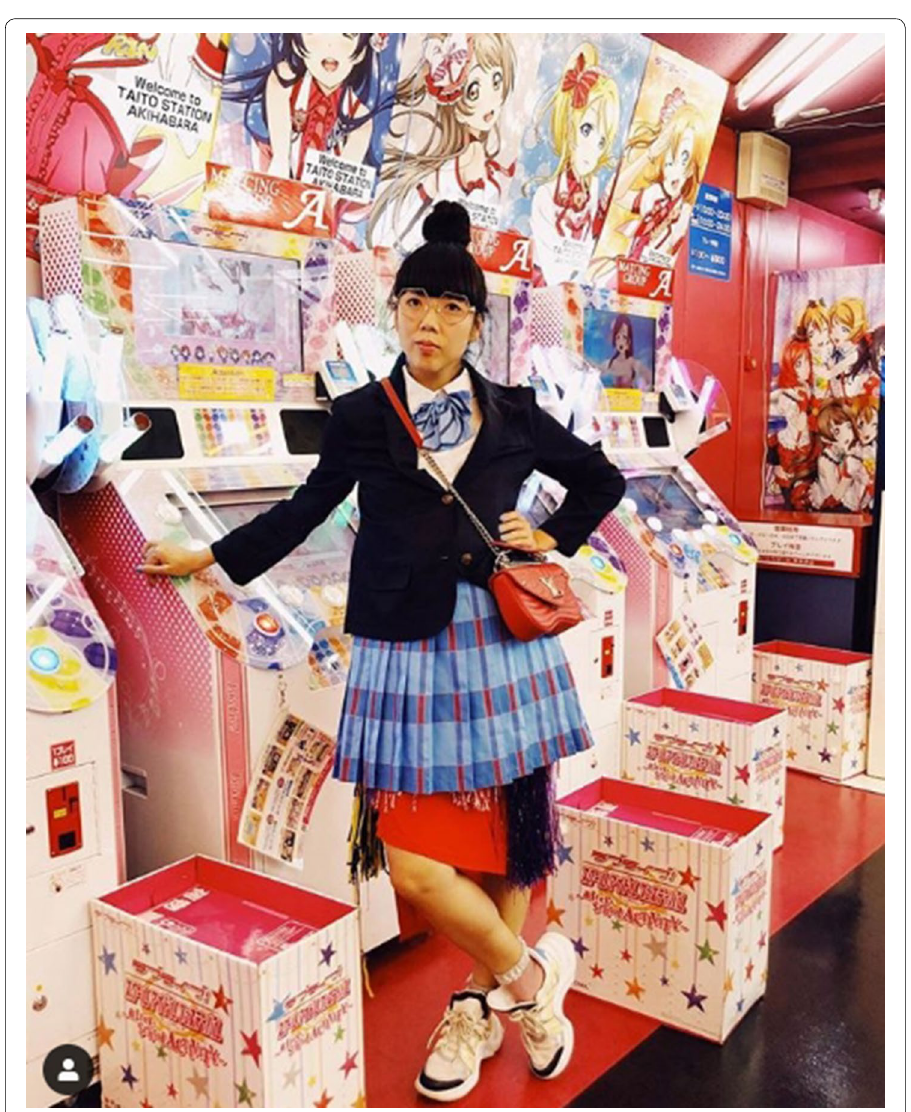
Fig. 20 Back to school feeling. https ://www.insta gram.com/p/Bm05o UMBef /, Accessed 5 October 2019 All images reprinted from www.insta gram.com/susie bubbl